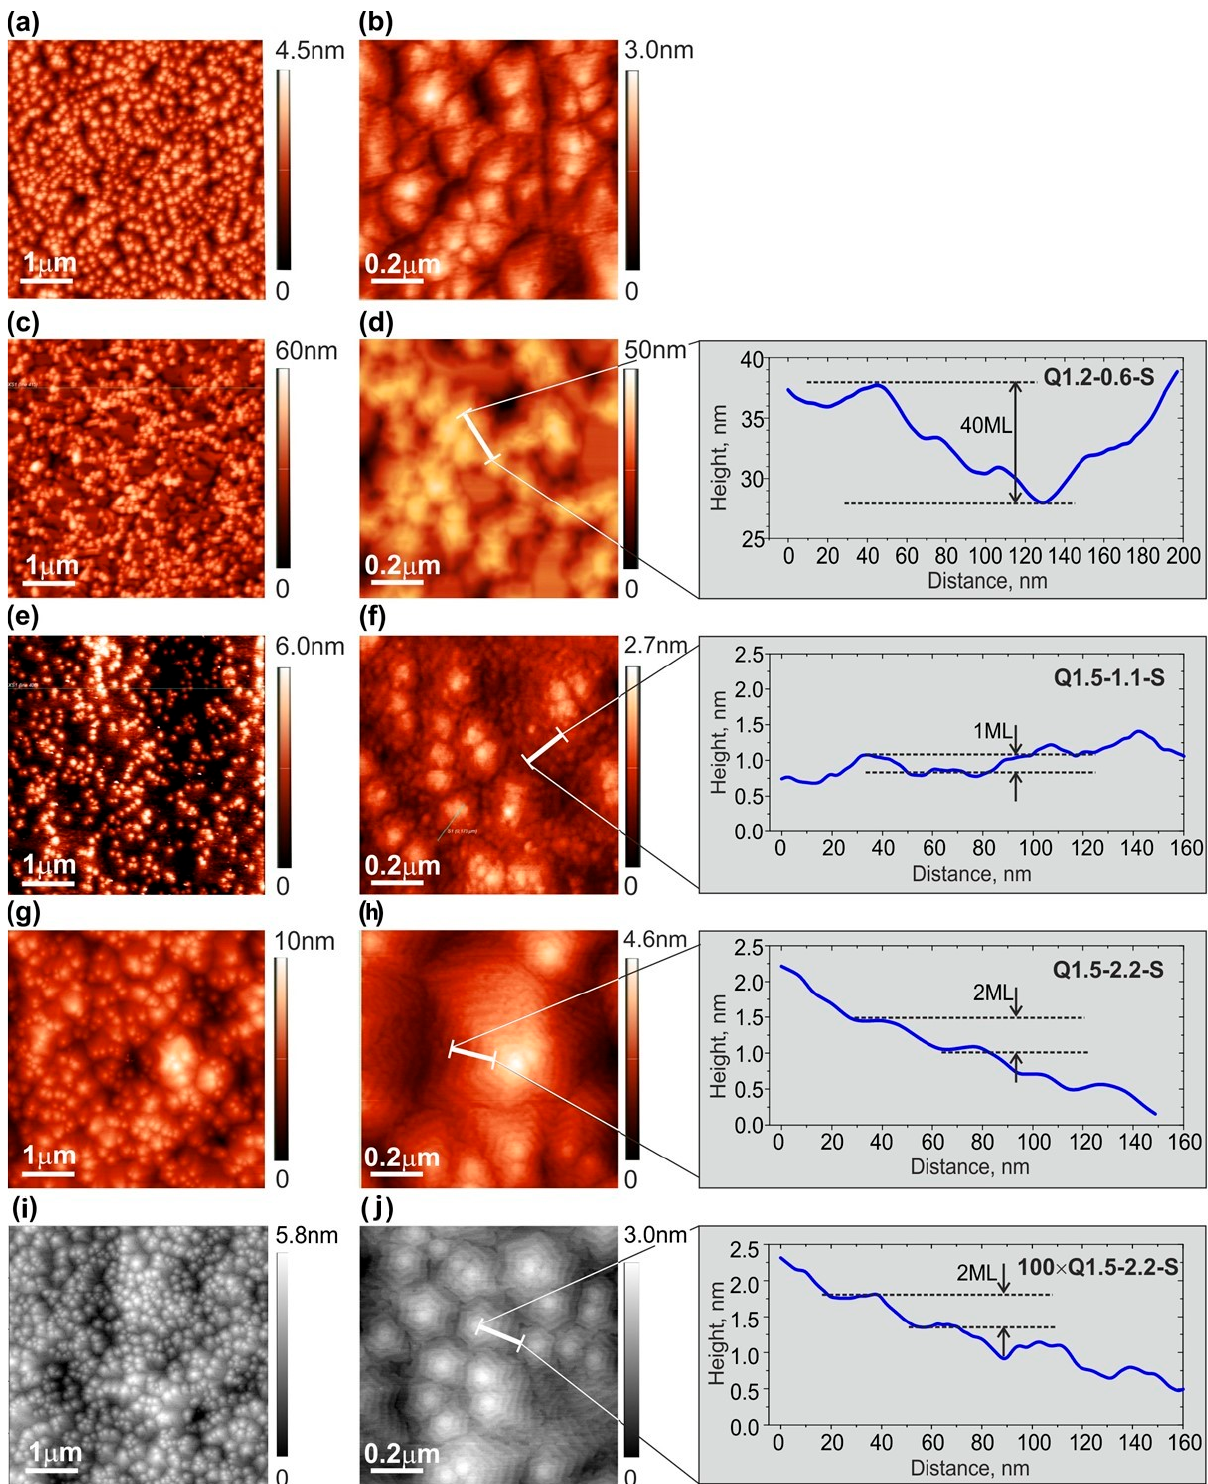
Figure 4. AFM images of the surfaces of a test AlN layer ( a , b ) and 400 × MQW structures with QWs grown at various Ga/N 2 * ratios: Q1.2-0.6-S ( c , d ); Q1.5-1.1-S ( e , f ); and Q1.5-2.2-S ( g , h ). AFM image of 100 × Q1.5-2.2-S structure grown under the same conditions as the previous one ( i , j ). AFM images have scanned areas of 1 × 1 µm 2 and 5 × 5 µm 2 . Inserts in figures ( d , f , h , j ) depict changes in the profile height along the white line segments plotted on these figures. Table 1. Characteristics of surface topographies for the AlN layer and MQW structures.